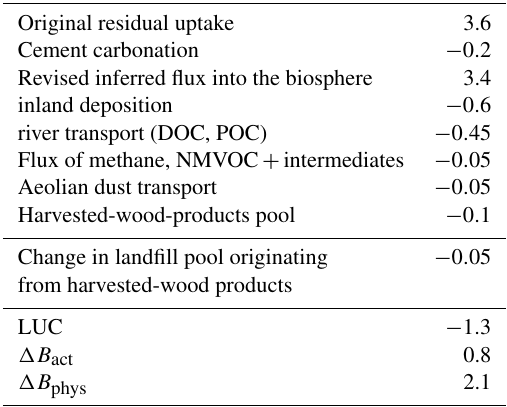
Table 4. Adjustments to the estimated change in the terrestrial bio- sphere (GtCyr − 1 ). The term (cid:49)B act refers to all actual biospheric carbon-stock changes, including those due to LUC whereas (cid:49)B phys excludes LUC effects and includes only physiological and age-class effects. The “inferred flux into the biosphere” is calculated as the residual sink minus cement carbonation. Original residual uptake 3.6 − 0 . 2